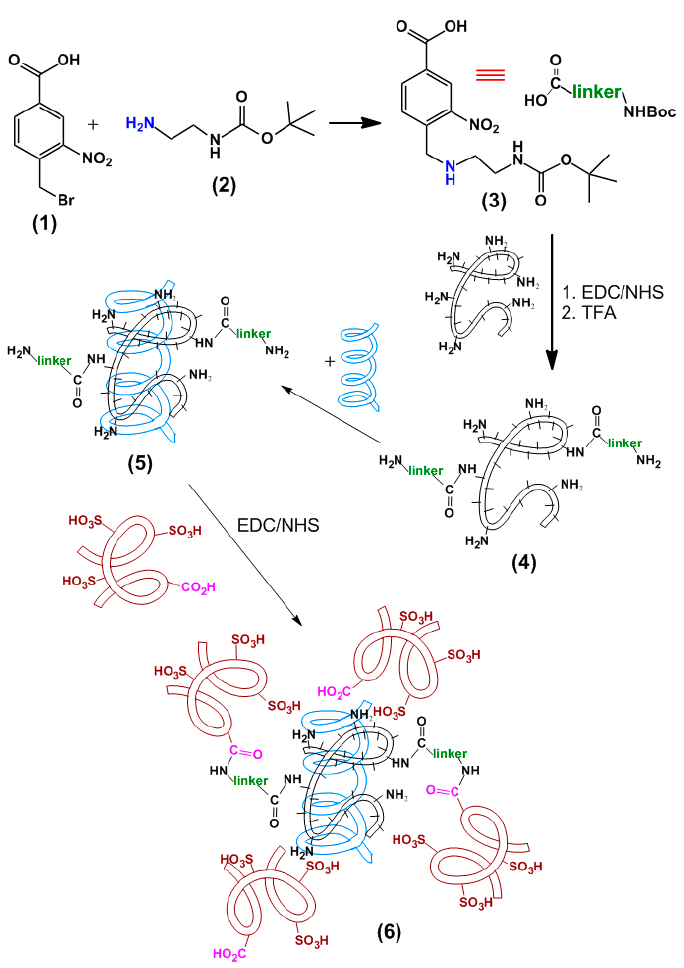
Figure 5. Assembling of photosensitive IPECs by cross-linking with photosensitive linker.